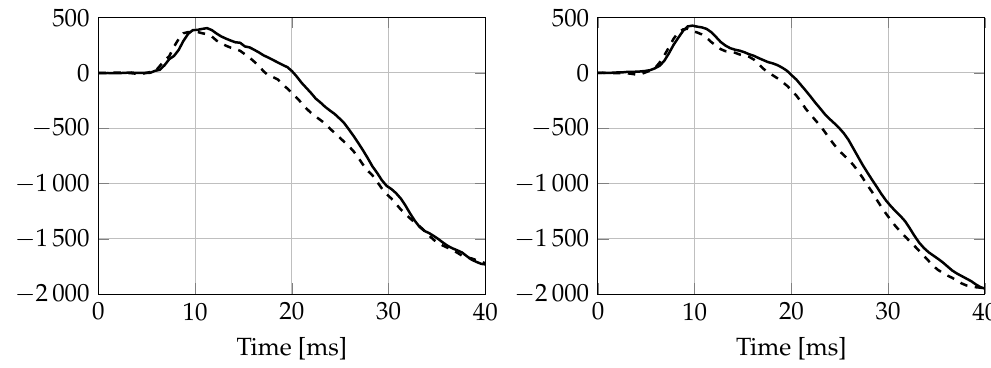
Figure 7. Signal recorded by two strain gauges during the water entry of a fiberglass/polyester wedge 4 mm thick with a deadrise angle of 35 ◦ entering the water from an impact height of 1.5 m (approximately 5 m/s). The graph on the right shows the strain measured at the center of the panel, while the graph on the left shows the strain close to the wedge tip. The full and the dashed lines represent two repetitions of the same experiment.